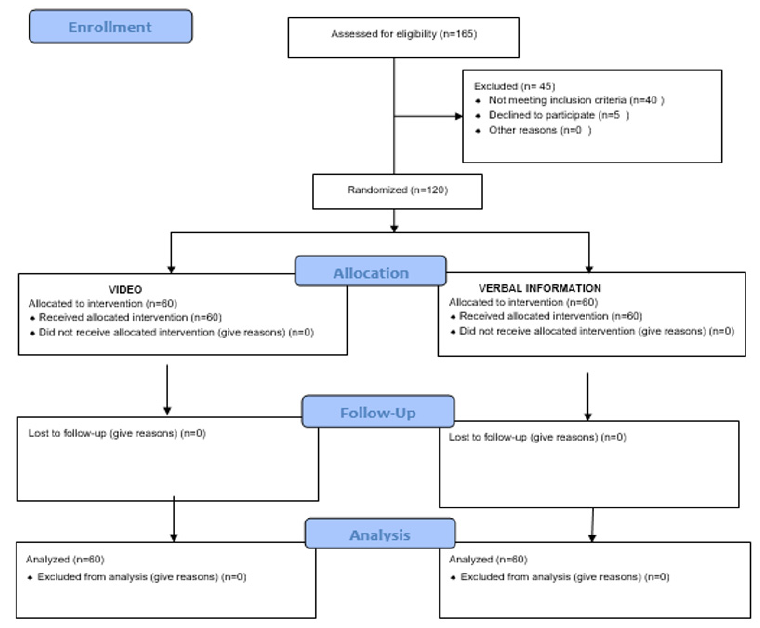
Figure 1. Consort 2010 flow